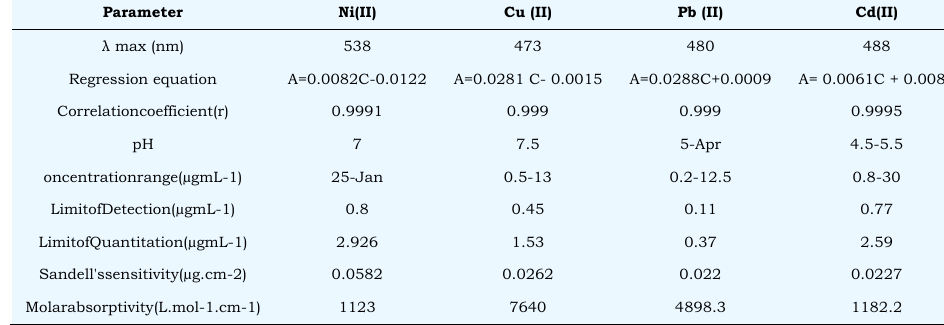
Table 3 Method validation of the spectrophotometric determination of